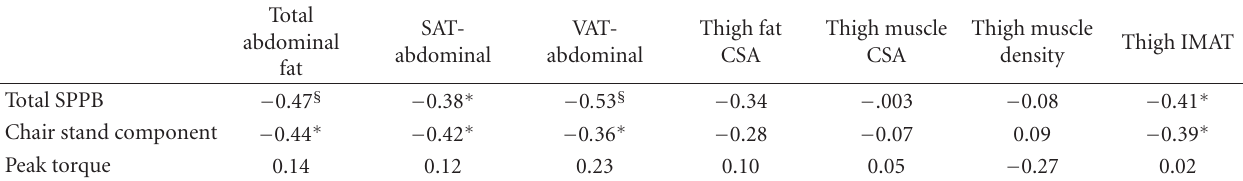
Table 4: Correlations between change in body composition measures with change in muscle strength and physical